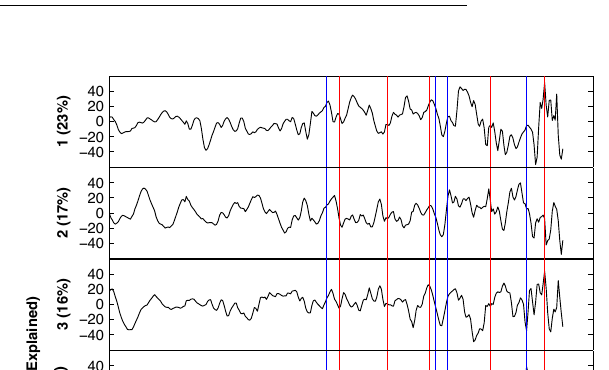
Table 2. Siple Dome shallow ice core data summary. The δ D, δ D standard deviation, net accumulation, and net accumulation standard deviation values pertain to the time period 1920-1995. Site Location Elevation Borehole Temp.